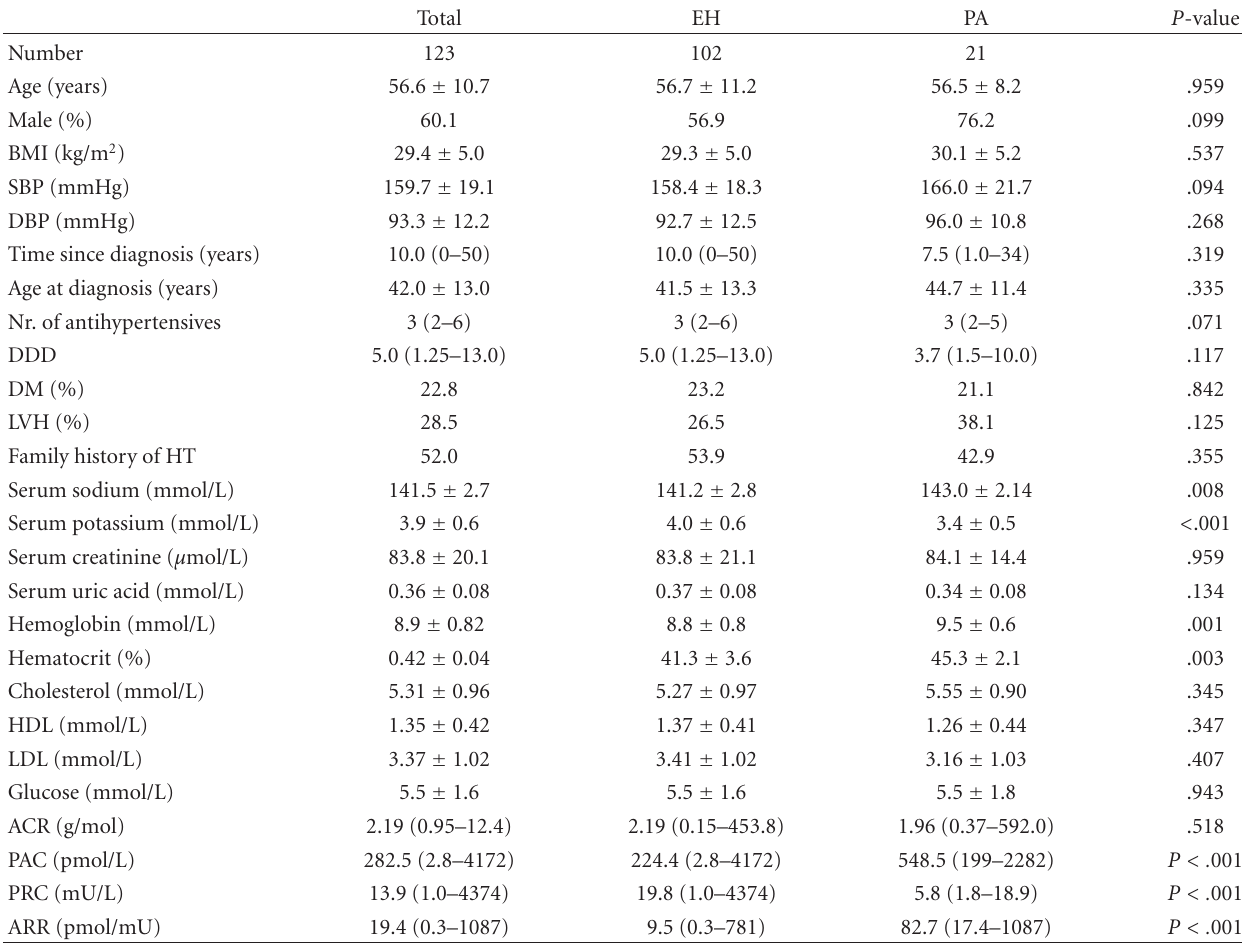
Table 1: Baseline characteristics of the study